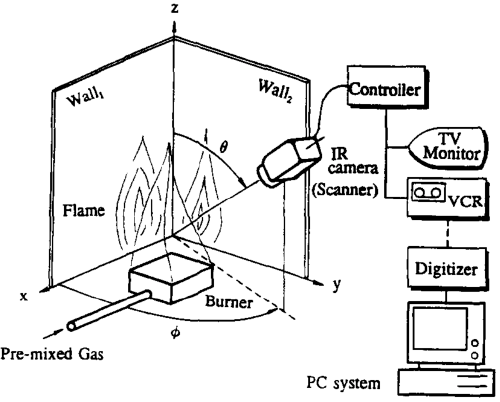
Figure 26. Experimental apparatus [162]. Figure 21. Experimental apparatus